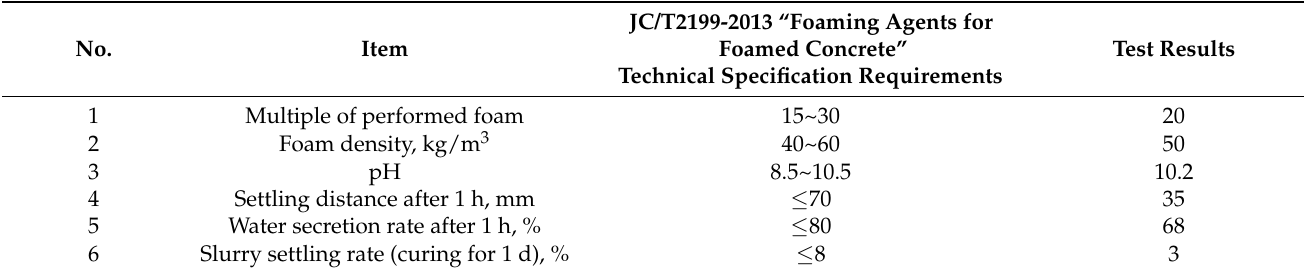
Table 3. Physical properties of foaming